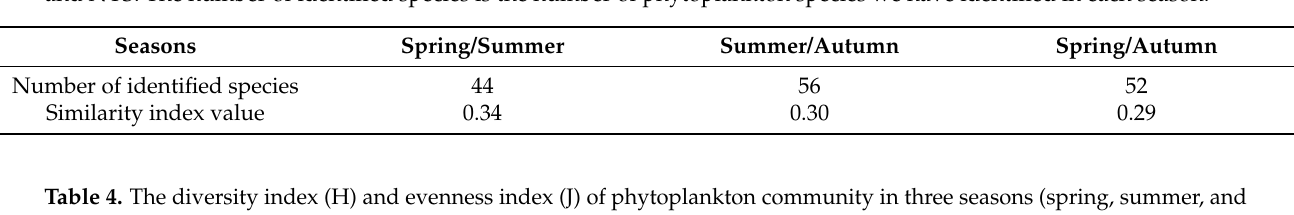
Table 3. The Jaccard similarity index of phytoplankton community in three seasons (spring, summer, and autumn) in the BS and NYS. The number of identified species is the number of phytoplankton species we have identified in each season.